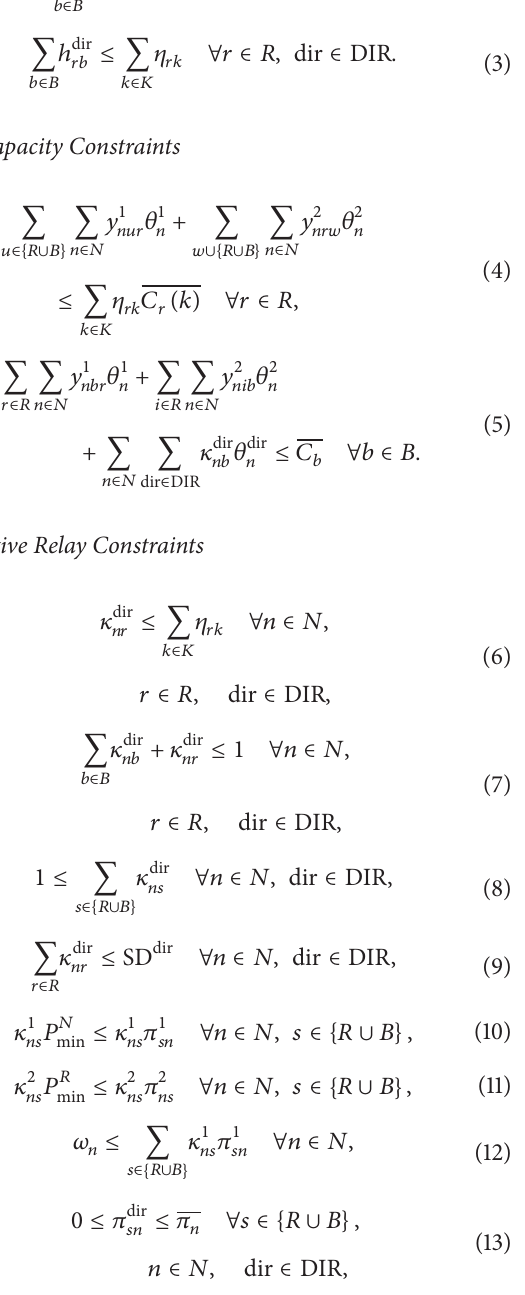
Figure 4: One OD pair routing multicast tree in UL